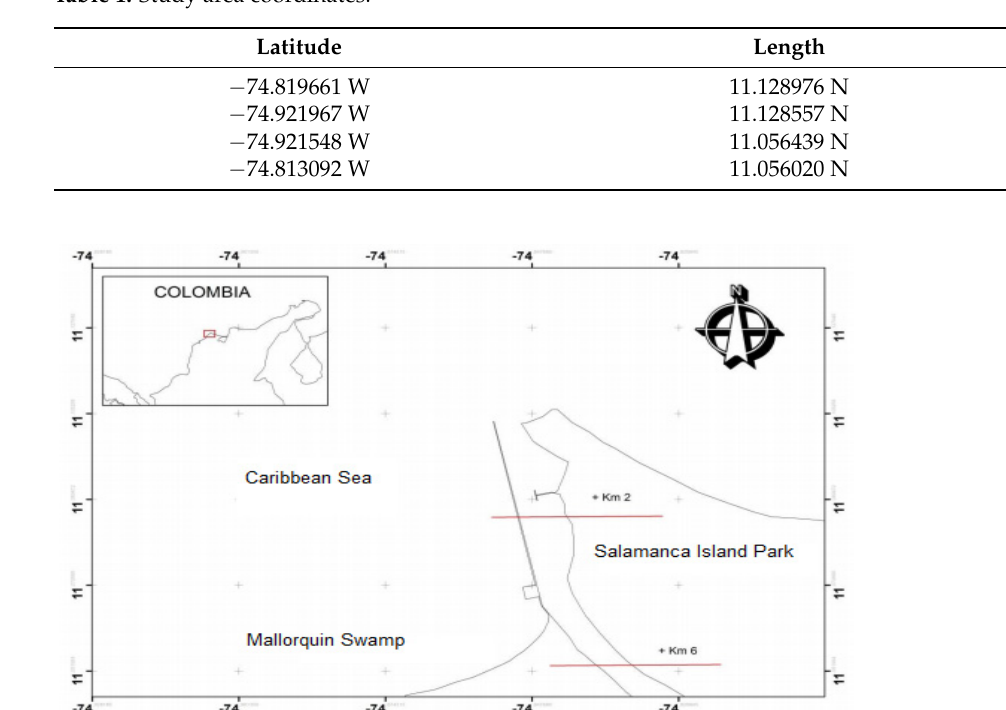
Figure 1. Study area